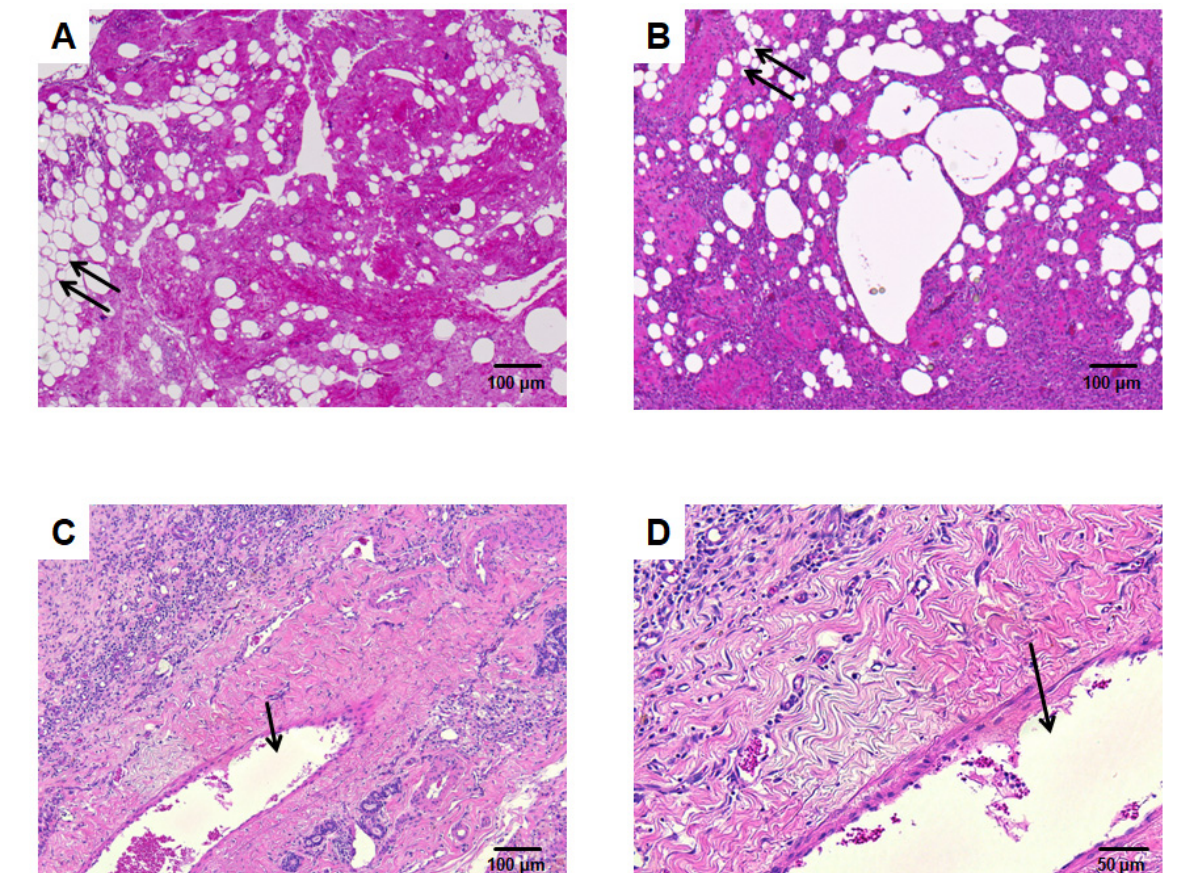
Figure 5. HE staining. ( A ) Mechanical SVF without AV loop explanted after 6 weeks. There are several parts that resemble adipocytes with large vacuoles (double arrow). ( B ) Mechanical SVF with AV shunt explanted after two weeks, while the adipocytes-like vacuoles decrease the interstitium is infiltrated by cells. ( C ) (lower magnification) and ( D ) (higher magnification) depict mechanical SVF supplied by an AV shunt after 6 weeks. A dense cell-rich tissue with no vacuoles is found. The arrow marks the tangentially cut AV shunt lumen.